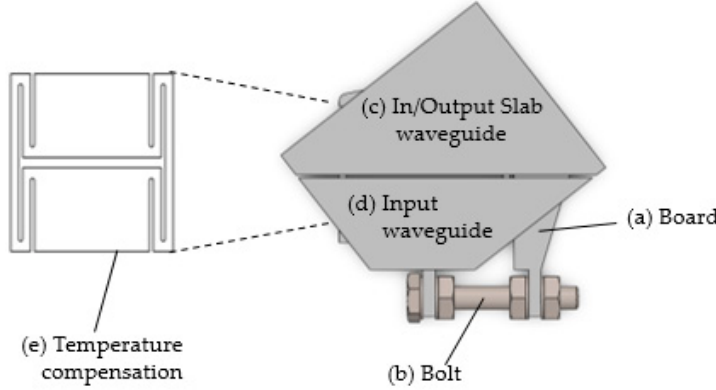
Figure 2. Temperature compensation board with chip assembled.